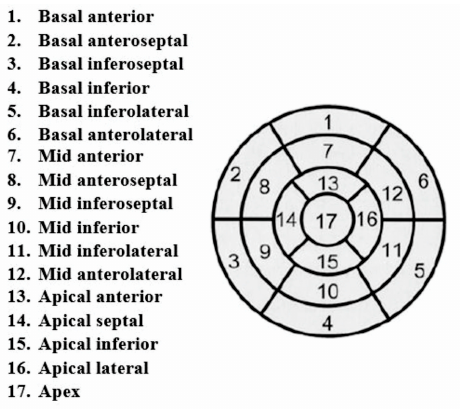
Figure 1. The nomenclature for the 17-segment heart model [8].